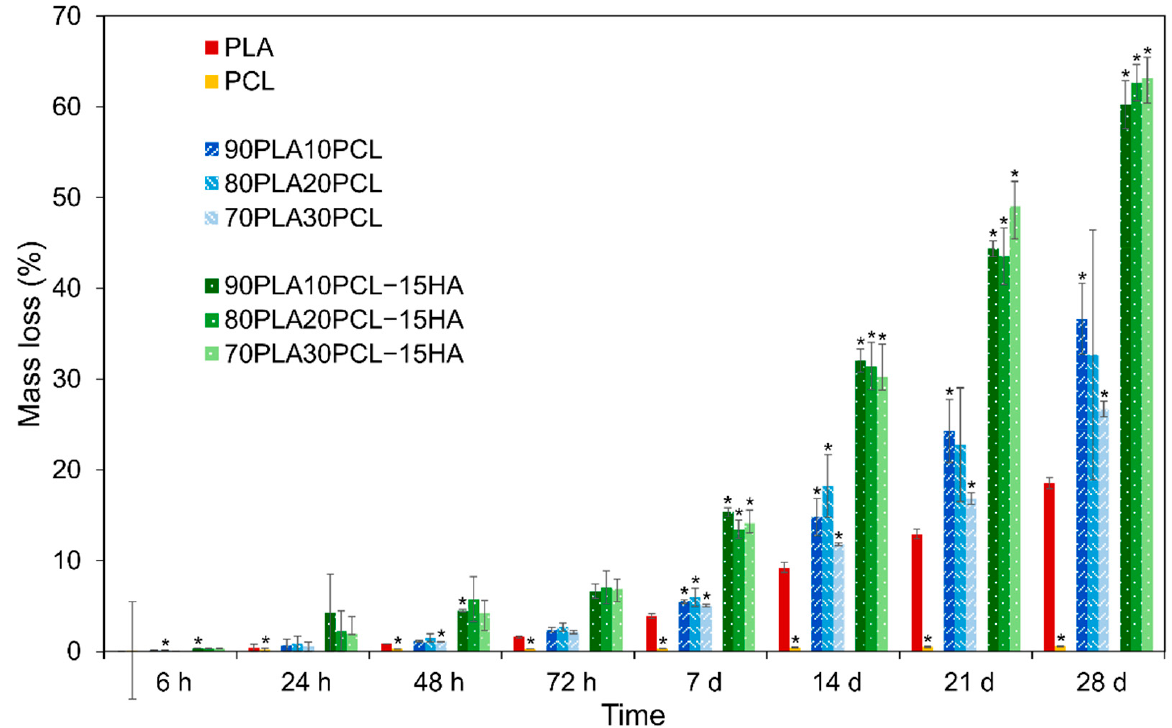
Figure 4. Percentage of mass loss for all materials during the four-week degradation period presented as mean ± standard deviation values. * denotes statistical significance compared to PLA ( p < 0.05) in the same time point.